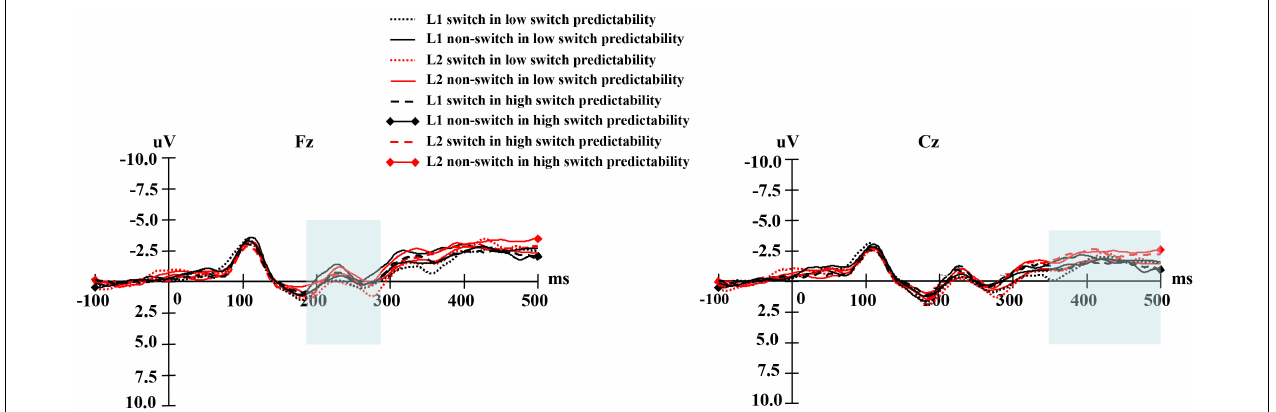
FIGURE 3 | (Left) Shows the averaged the early phase and (right) the averaged the late phase elicited by digits.